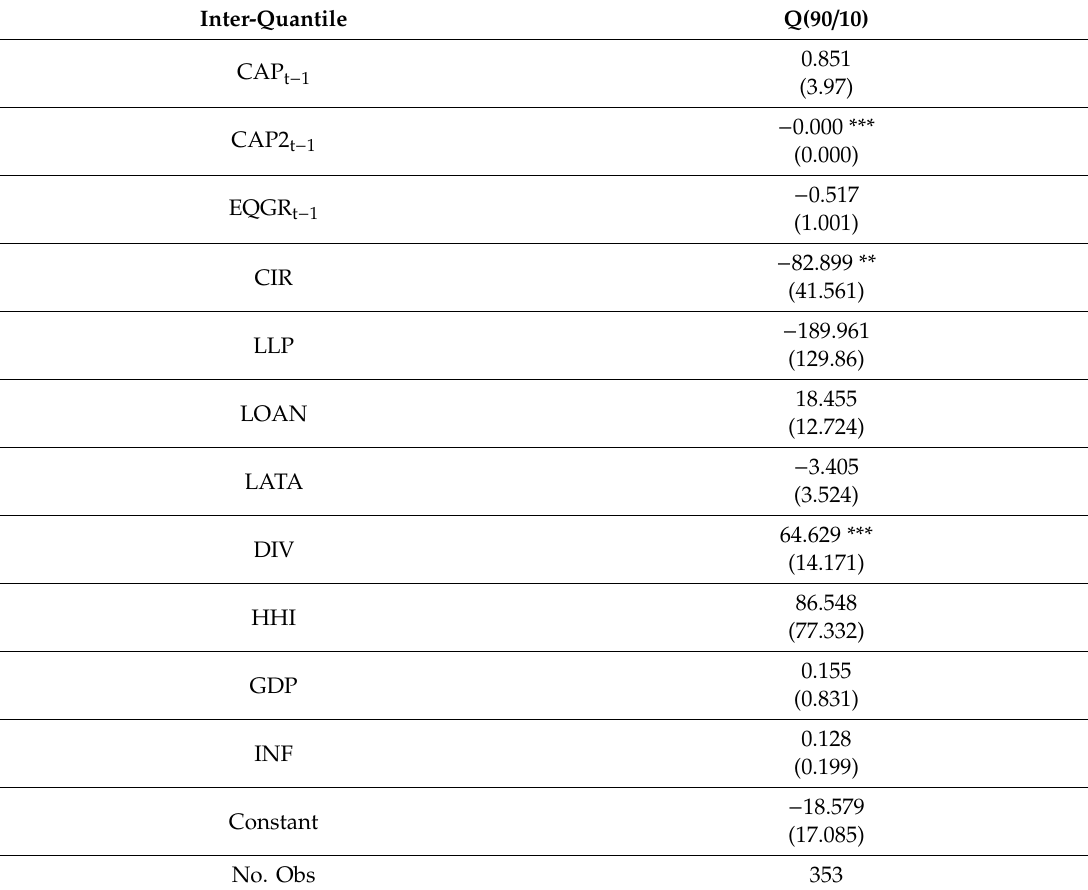
Table 7. The result of inter-quantile